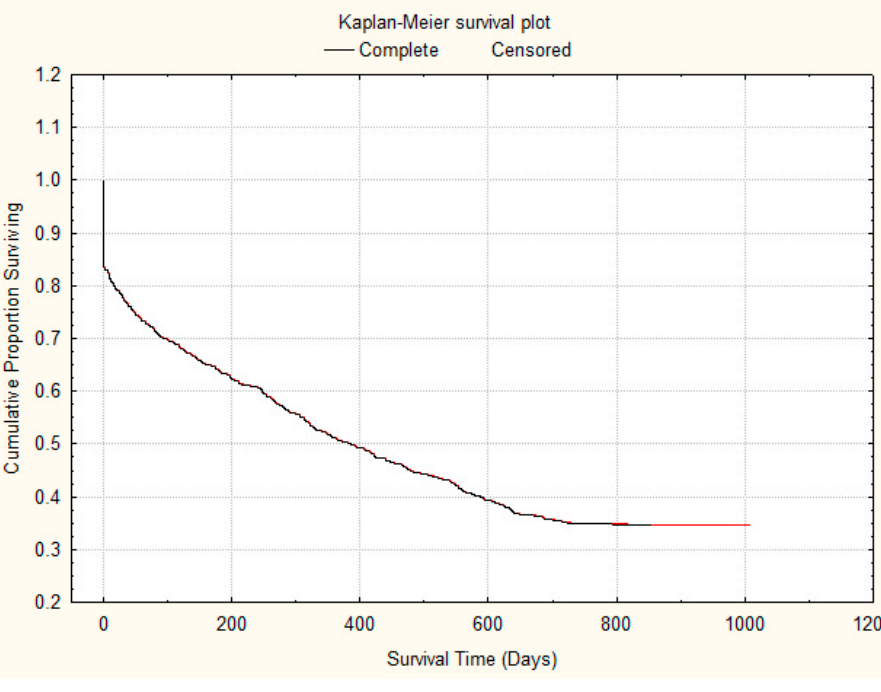
Figure 2. Kaplein-Meier showing survival over days during follow-up period.